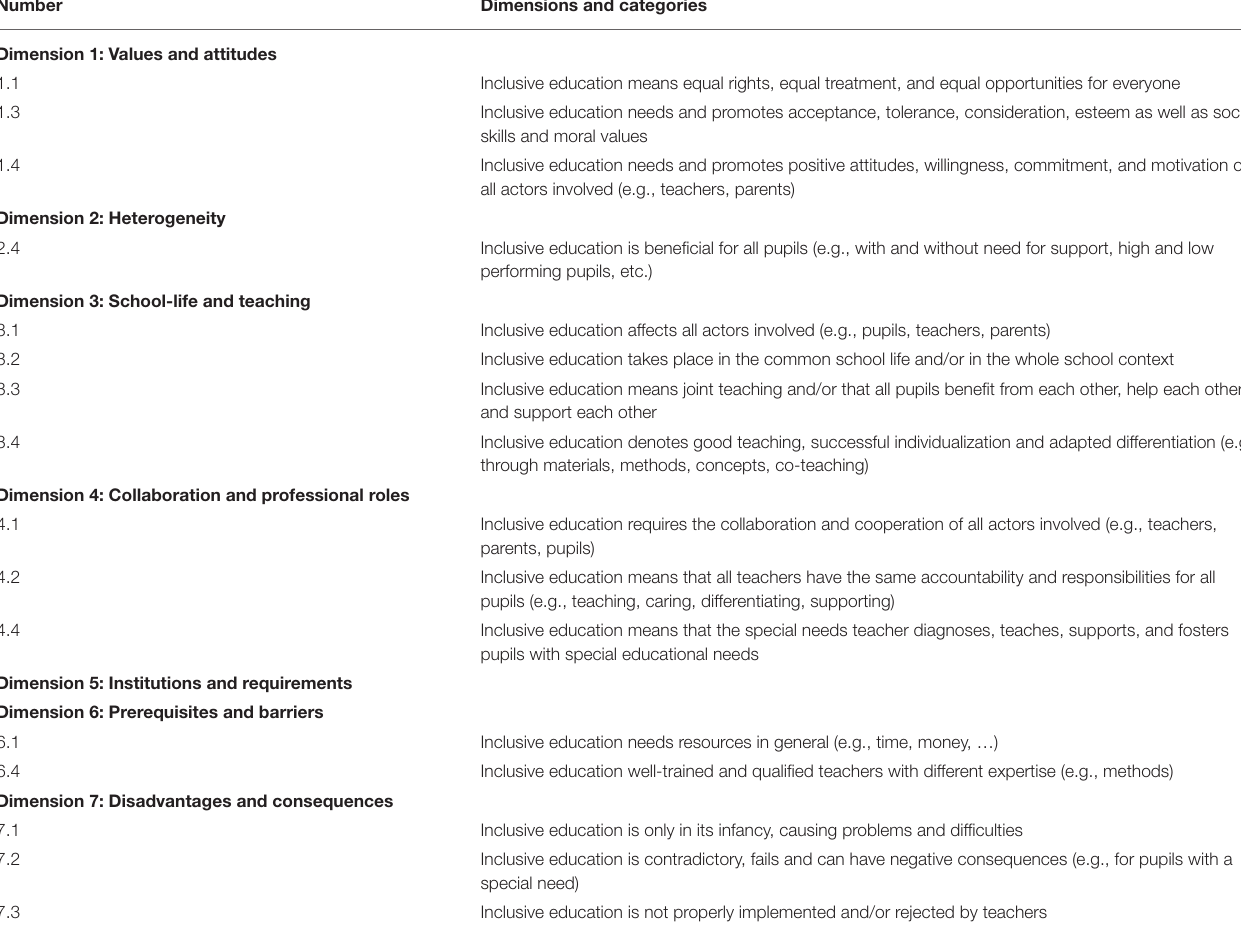
TABLE 1 | Excerpt of final system of categories (for complete system see Ritter et al.,